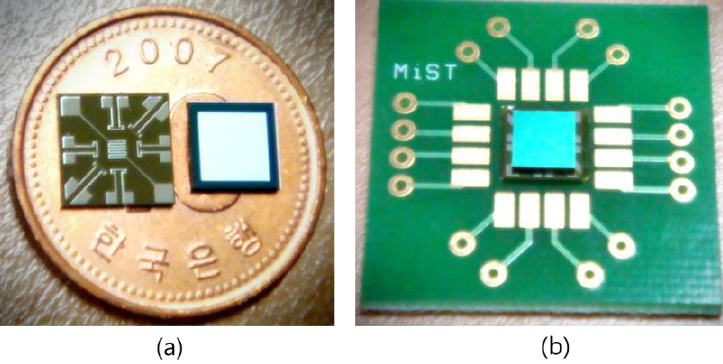
Figure 3. Thermal convection-based accelerometer on ( a ) coin and ( b ) PCB chip.